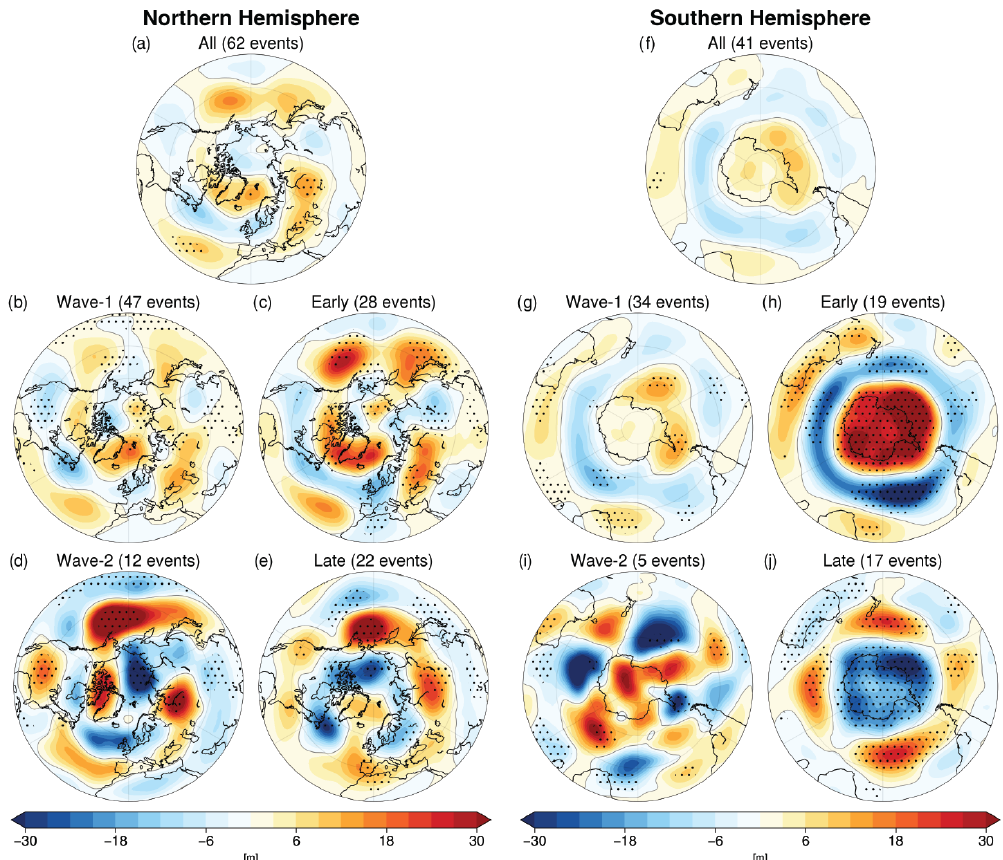
Figure 8. Composite of the linearly detrended 500hPa geopotential height anomalies (m) from JRA-55 data for (a, f) all FSW events based on the 50hPa dates and classified as (b, g) wave-1, (d, i) wave-2, (c, h) early, or (e, j) late averaged over the 7–30d after the central FSW date (i.e., lags of 7–30d) for (a–e) the NH and (f–j) the SH extratropics. Stippling in (a, f) indicates regions where the anomaly composites are significantly different from zero at the 95% confidence level according to a t test, while stippling in other panels shows where composites are significantly different from each other (e.g., wave-1 vs. wave-2, early vs. late) according to a 1000-sample bootstrap analysis (with